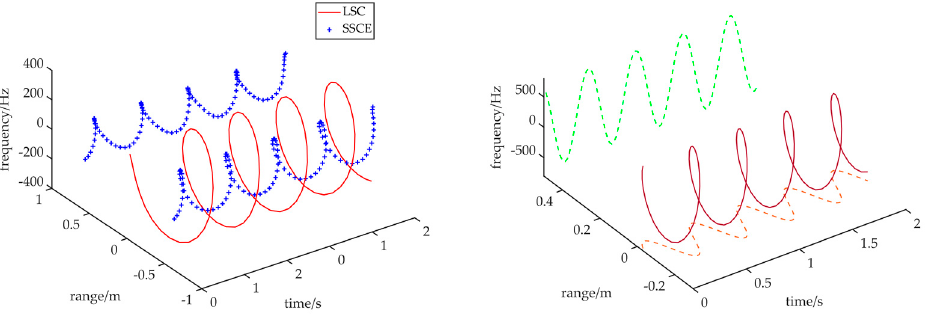
Figure 7. Parameter estimation method under case 1.